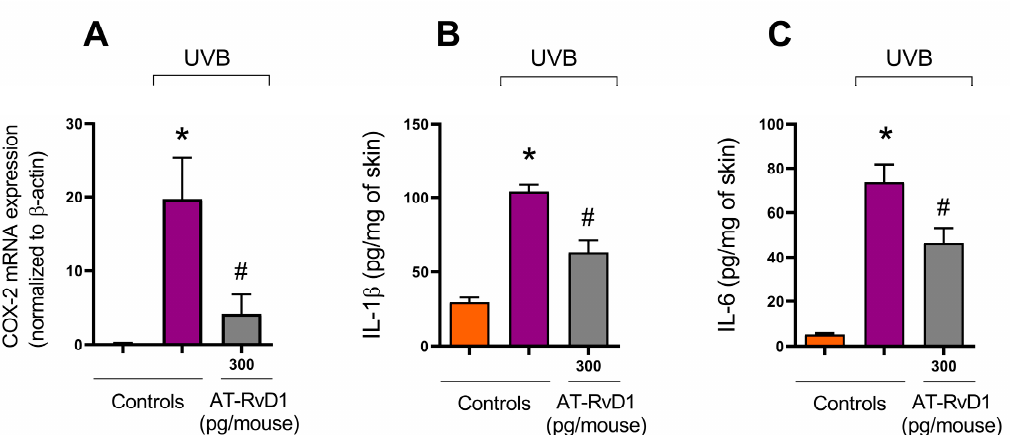
Figure 6. Effect of 300 pg/mouse AT-RvD1 on COX-2 mRNA expression determined using reverse transcriptase quantitative polymerase chain reaction (RT-qPCR) and on cytokine levels determined using ELISA in hairless mouse skin exposed to 4.14 J/cm 2 UVB radiation. Skin samples for the determination of COX-2 mRNA expression and for cytokine levels were collected 4 h after UVB exposure. COX-2 mRNA expression ( A ); IL-1 ꞵ ( B ); IL-6 ( C ). Bars represent means ± SEM. Two separate experiments with five groups of 5 mice per group per experiment were performed. Statistical analysis was performed by one-way ANOVA, followed by Tukey´s post hoc test. * p < 0.05 compared to the nonradiated control group (orange bars); # p < 0.05 compared to the radiated control group (purple bars).